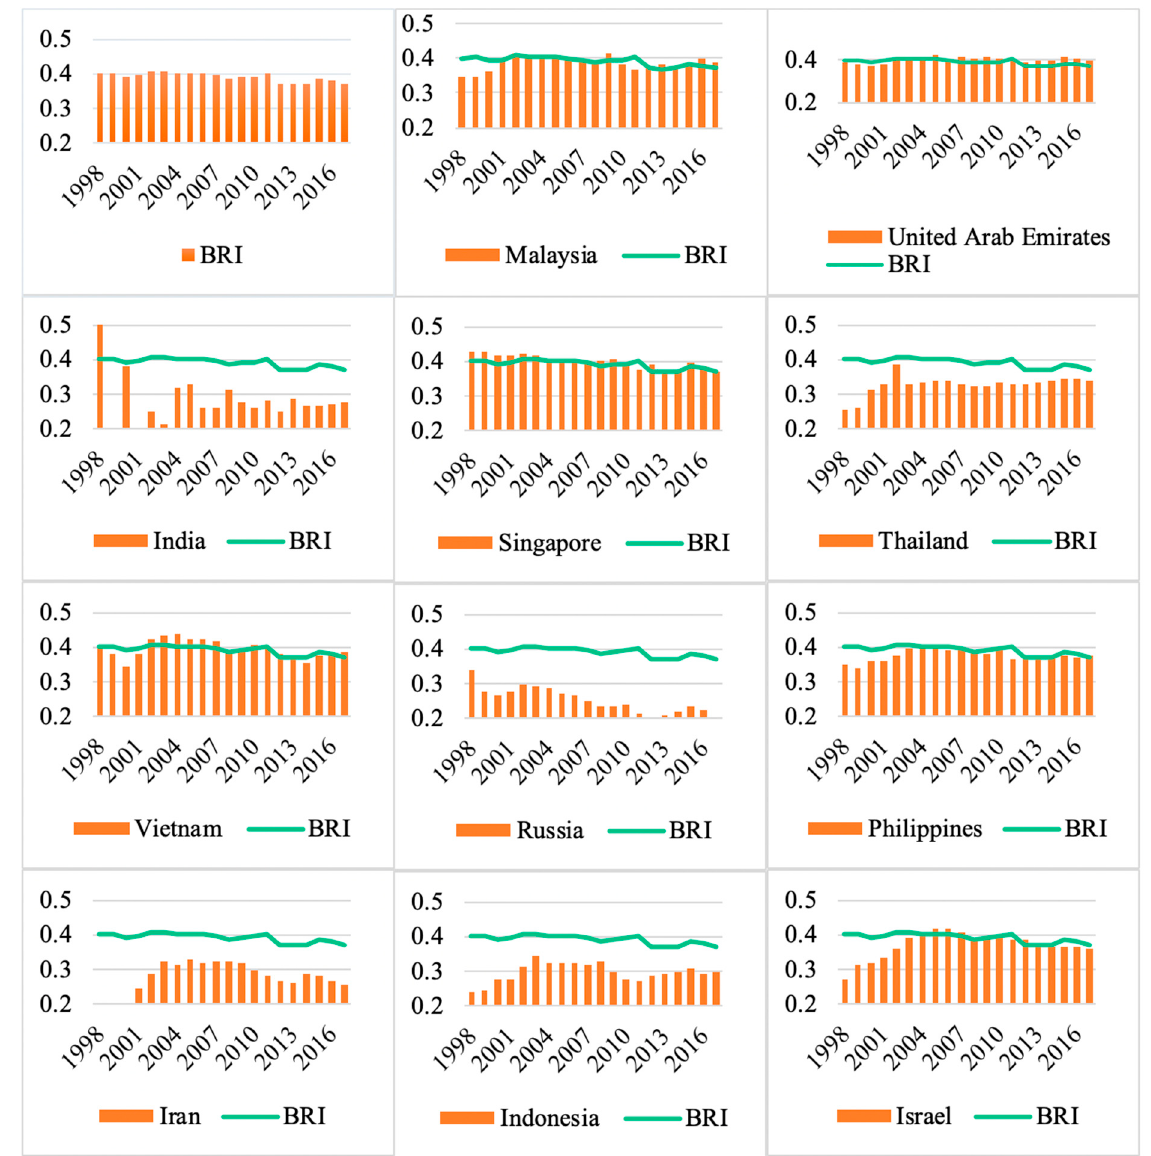
Figure 4. Quality of wooden furniture exported by China to major markets in the “Belt and Road Initiative”